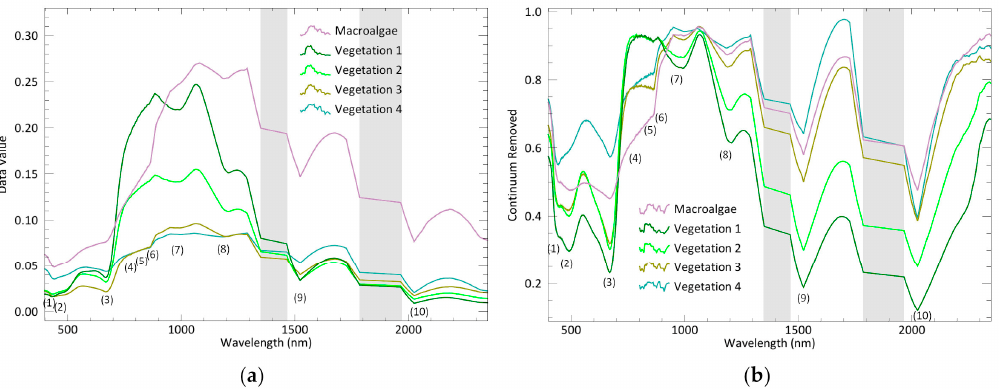
Figure 5. Spectral profiles ( a ) and the corresponding continuum removal transformations ( b ) for the salt marsh vegetation classes identified in Cadiz Bay. The grey areas highlight the water vapour absorbance regions (1350–1460 nm and 1790–1960 nm) excluded from the hyperspectral processing. The numbers in brackets indicate the absorbance peaks of the spectral signatures. Note that minimum values are absorption peaks and maximum values are reflectance peaks. Table 1. Wavelengths of the absorption peaks detected in the spectral signature of the marsh vege- tation classes of Cadiz Bay. The numbers in the column headers correspond to the peaks indicated in Figure 5. Units: nm.